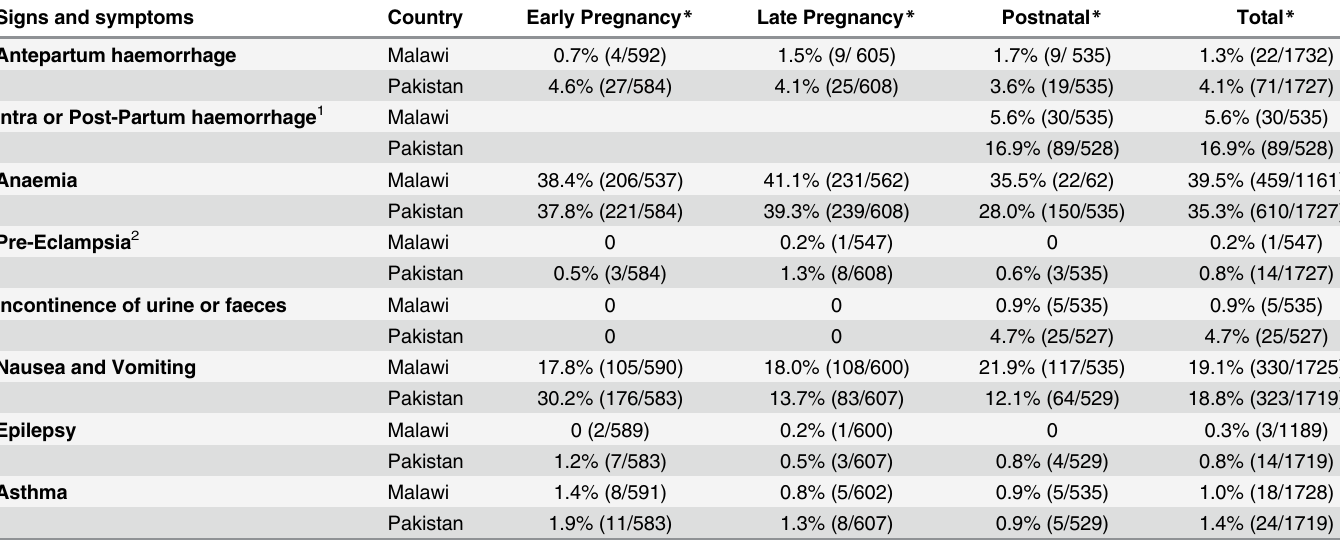
Table 5. Signs and symptoms of non-infective